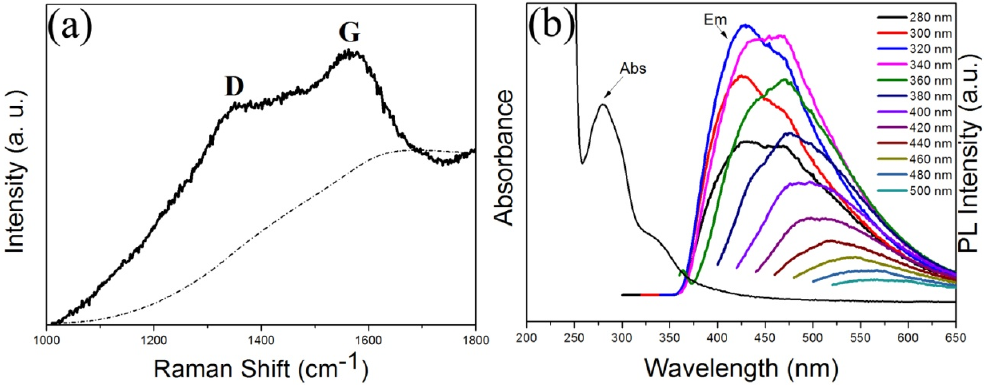
Figure 4. ( a ) Raman absorbance and the background is given by the dashed line; ( b ) photoluminescence (PL) spectra of the CDs at different excitation wavelengths.